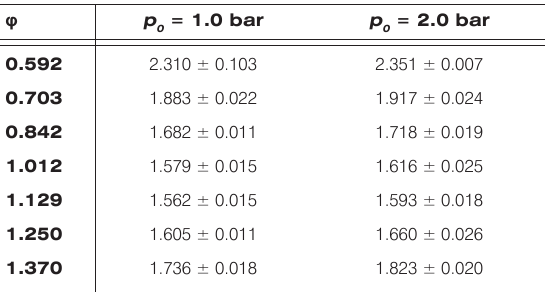
Figure 16. The ignition temperatures in the stoichiometric ethane- air flame at various initial temperatures and p Table 3. Thermal coefficients μ of burning